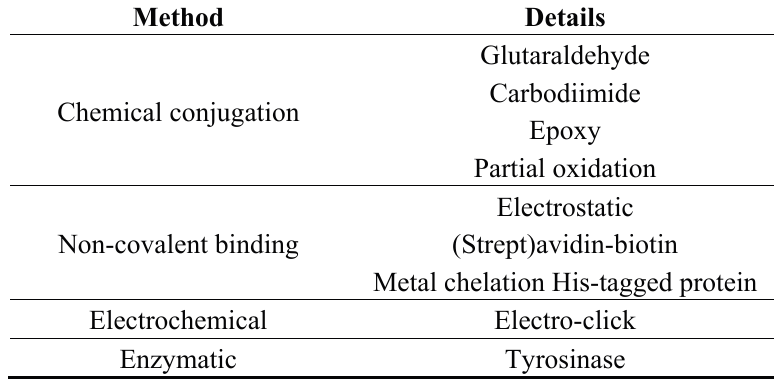
Table 4. Methods to couple proteins to chitosan to confer biological